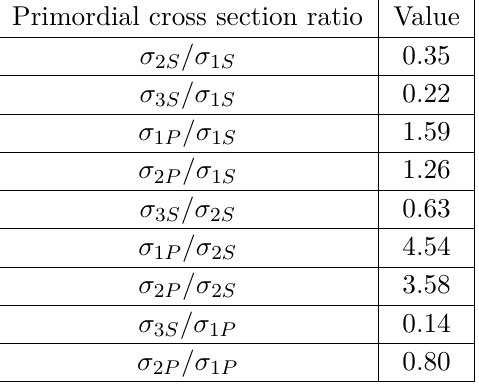
Table 3. Ratios of primordial cross